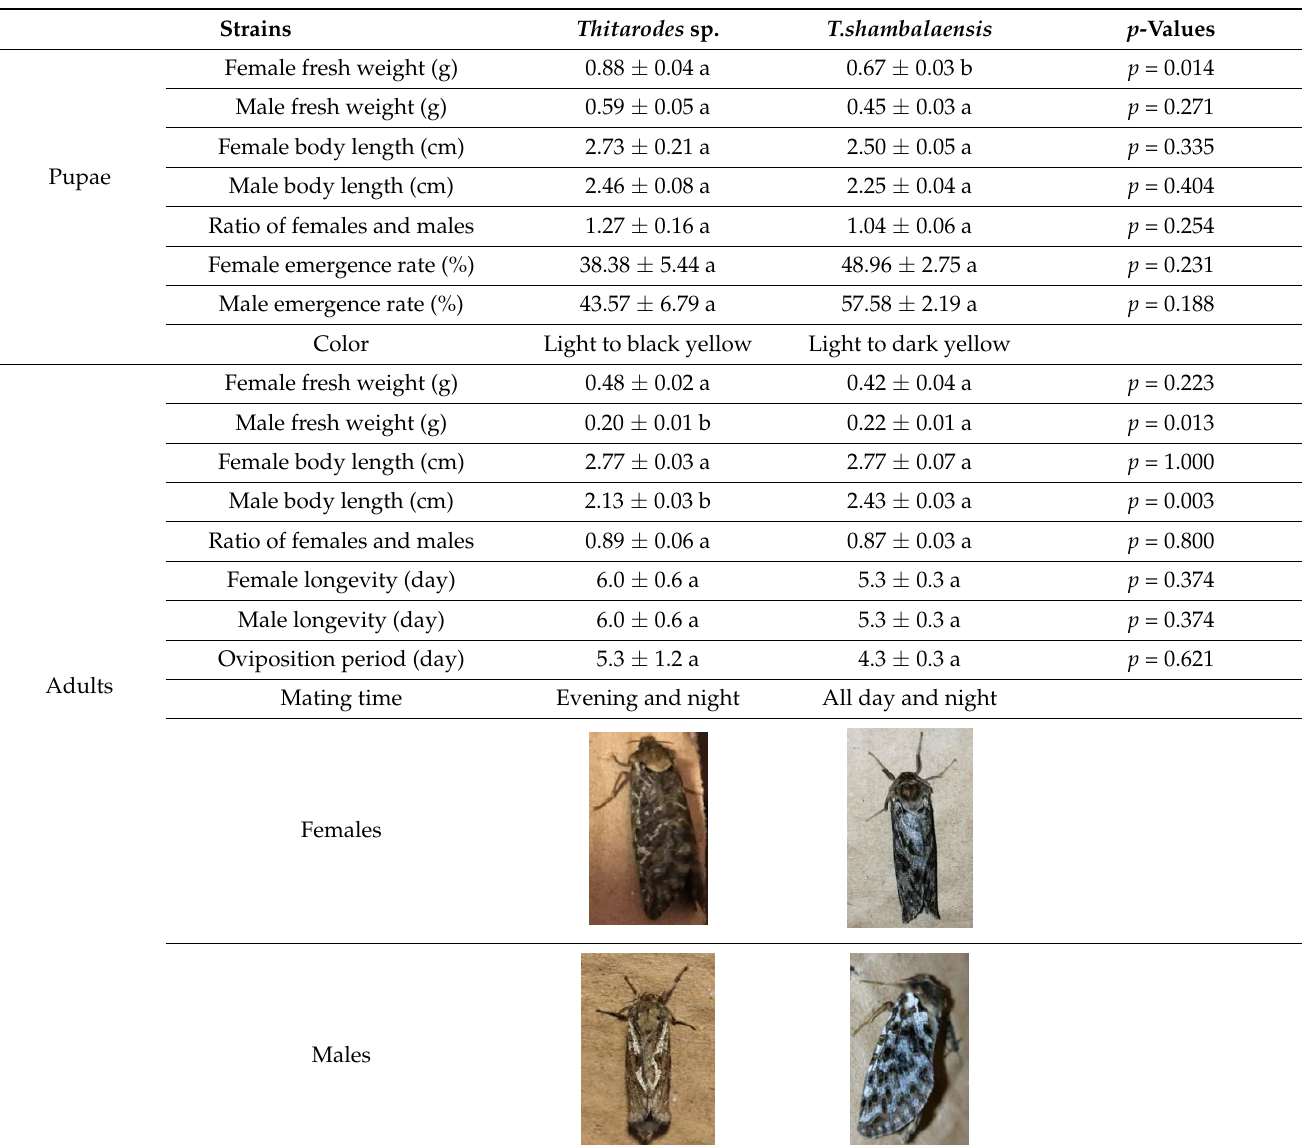
Table 1. Morphological and biological characters of Thitarodes sp. and T. shambalaensis . Strains Thitarodes sp.